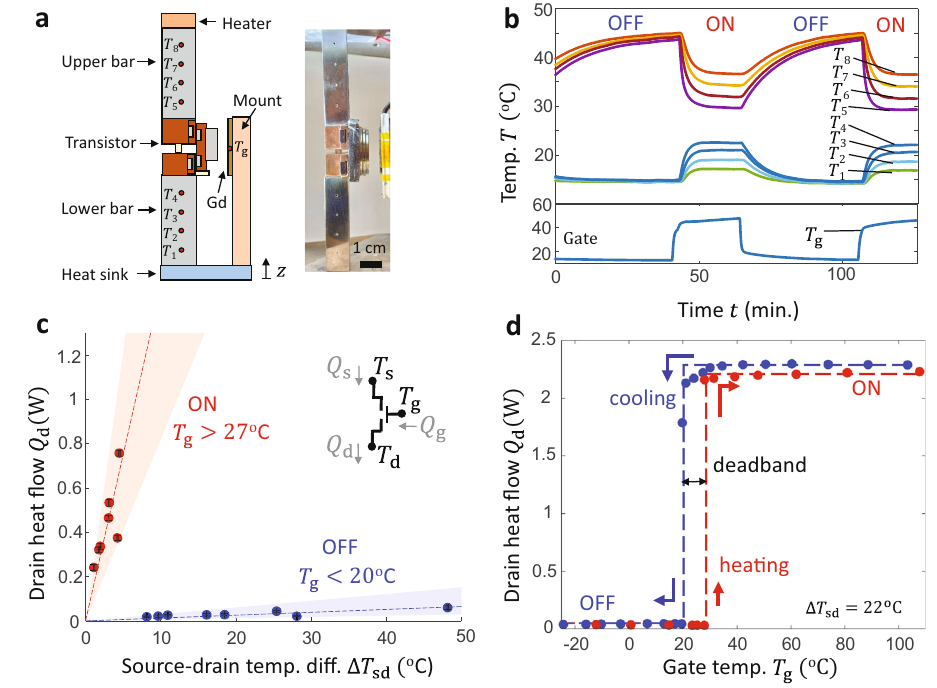
Fig. 2 | Thermal transistor measurements. a Schematic (left) and optical image (right) of reference bar measurements used to quantify the thermal transistor performance under high vacuum. b Time-dependent measurements show tran- sistor cycling over two OFF to ON cycles. We set the transistor state by controlling T g (bottompanel)andmeasurethereferencebartemperatures to extract Q d , T s , and T d . c Reference bar measurements show that the transistor achieves a T g -controlled thermal switching ratio G on = G off =109±44,